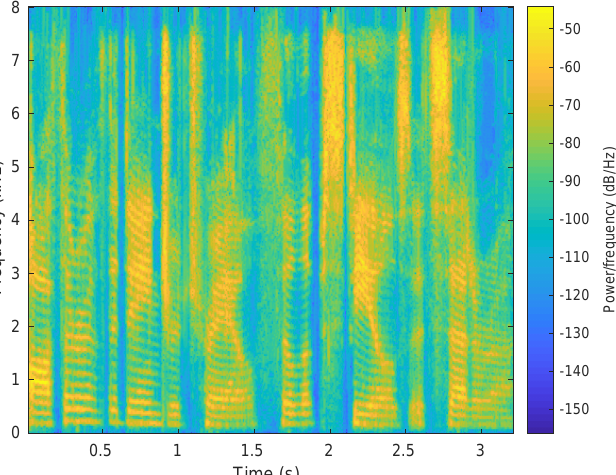
Figure 5. One spectral segment feature for male, female and warped male to female.